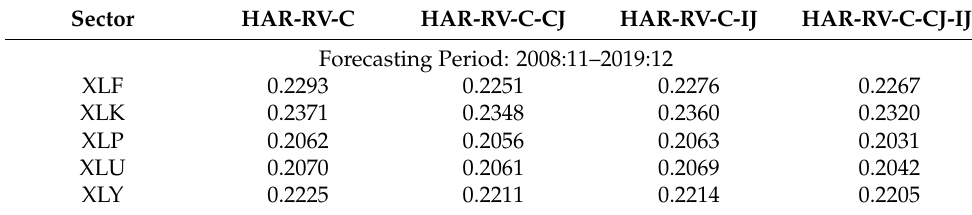
Table 13. Mean absolute forecasting error